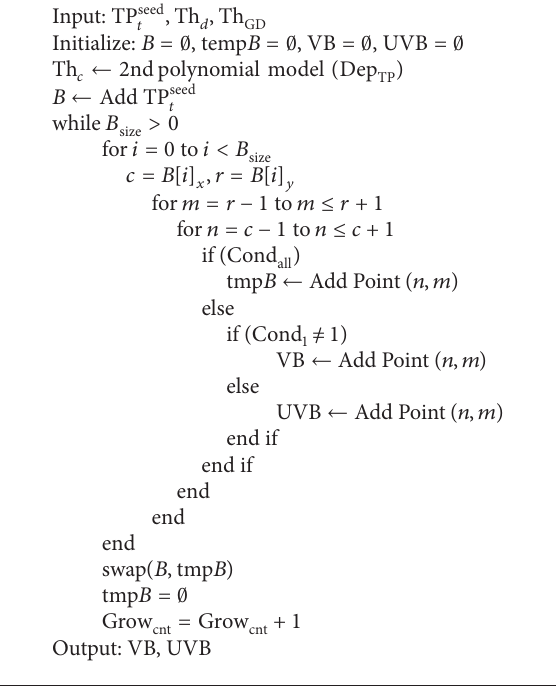
Algorithm 4: Algorithm for region